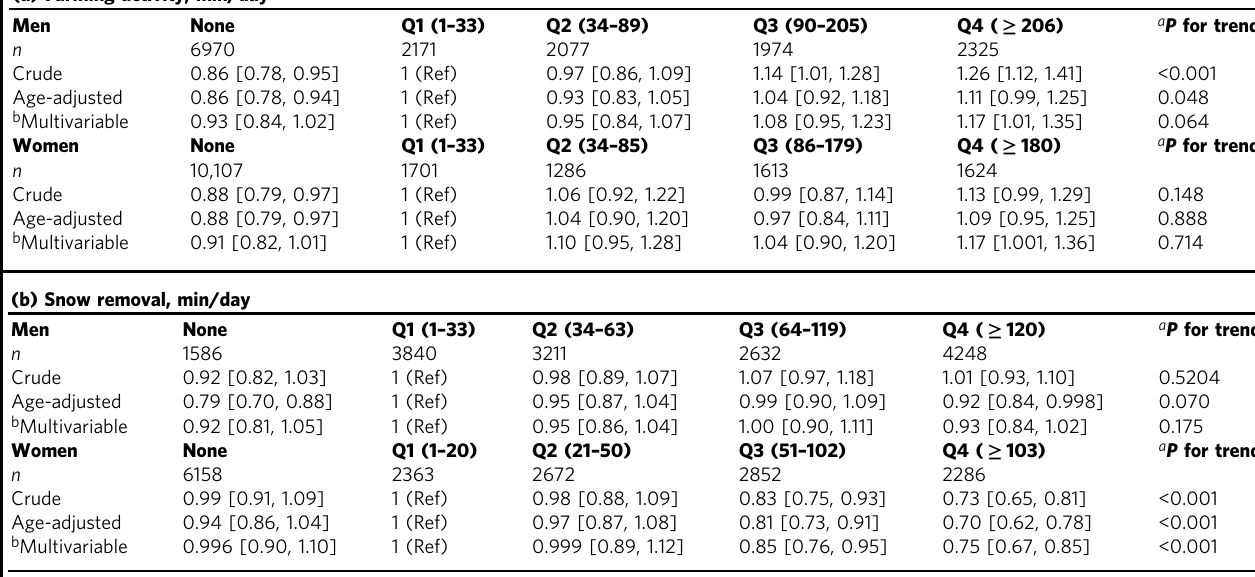
Table 2 Odds ratios (95% CI) of happiness according to farming activity (a) and snow removal (b), by sex. (a) Farming activity,